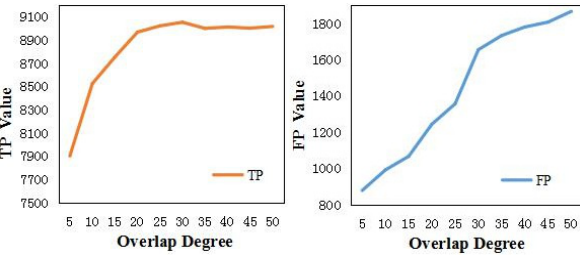
Figure 8. TP and FP values for different overlap degree, Hannover